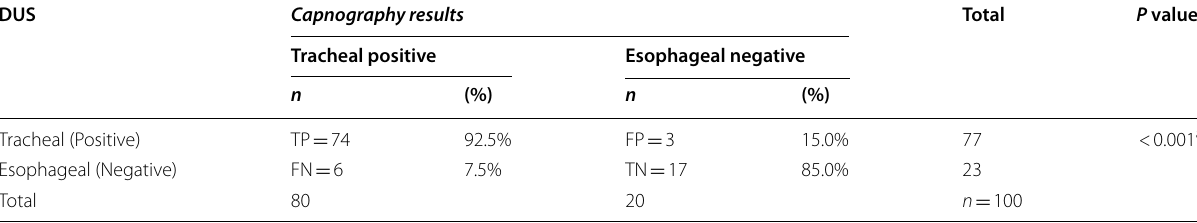
Table 5 A comparison of DUS results with the capnography results